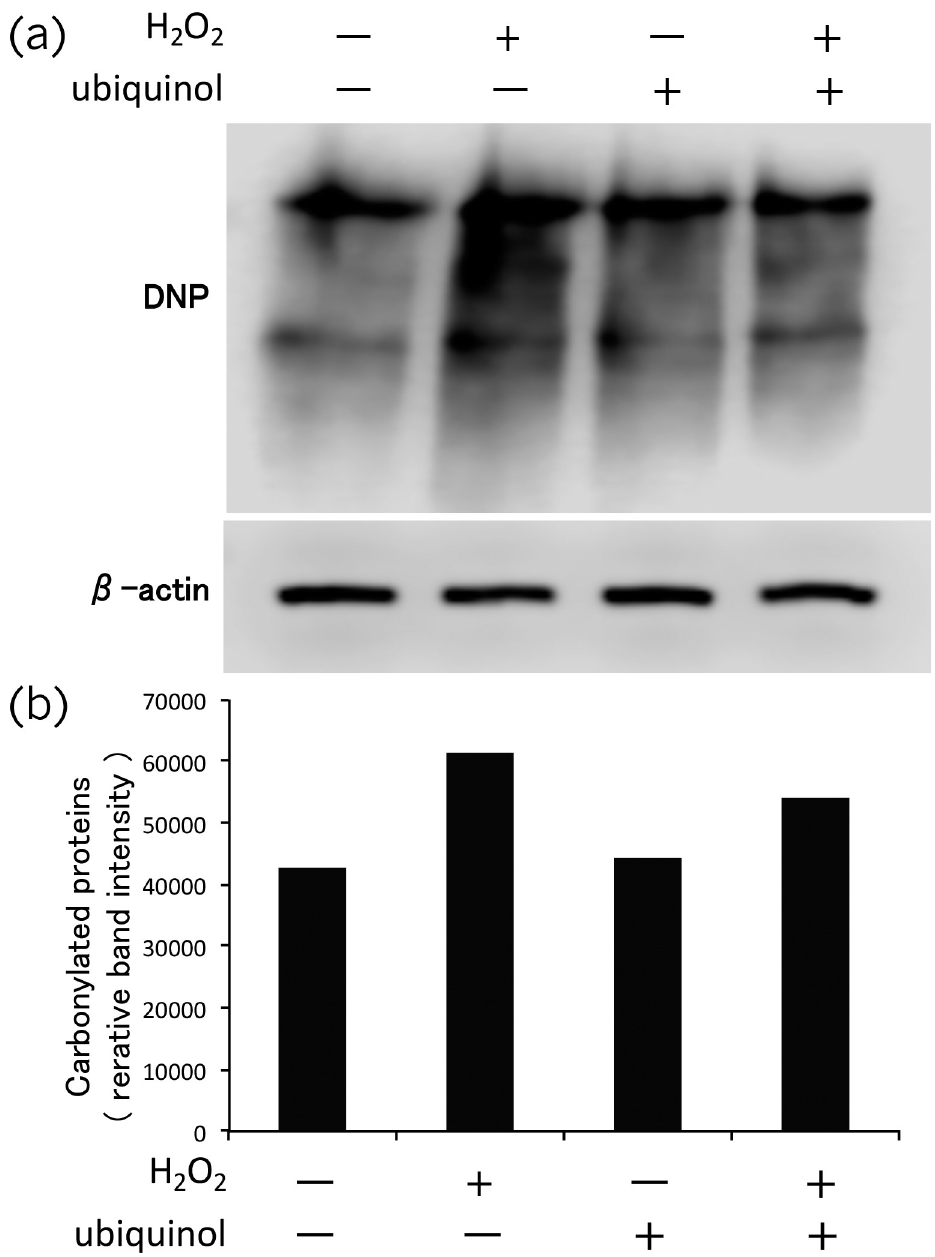
Fig 6. Protein carbonylation assay. Oxidation of proteins in human salivary gland (HSG) cells induced by 20 mM H 2 O 2 was inhibited by 100 nM ubiquinol. (a) Western blots of carbonylated proteins stained with anti-DNP antibody and β -actin in the same samples. (b) The staining intensity of carbonylated protein bands was quantified by using Image J